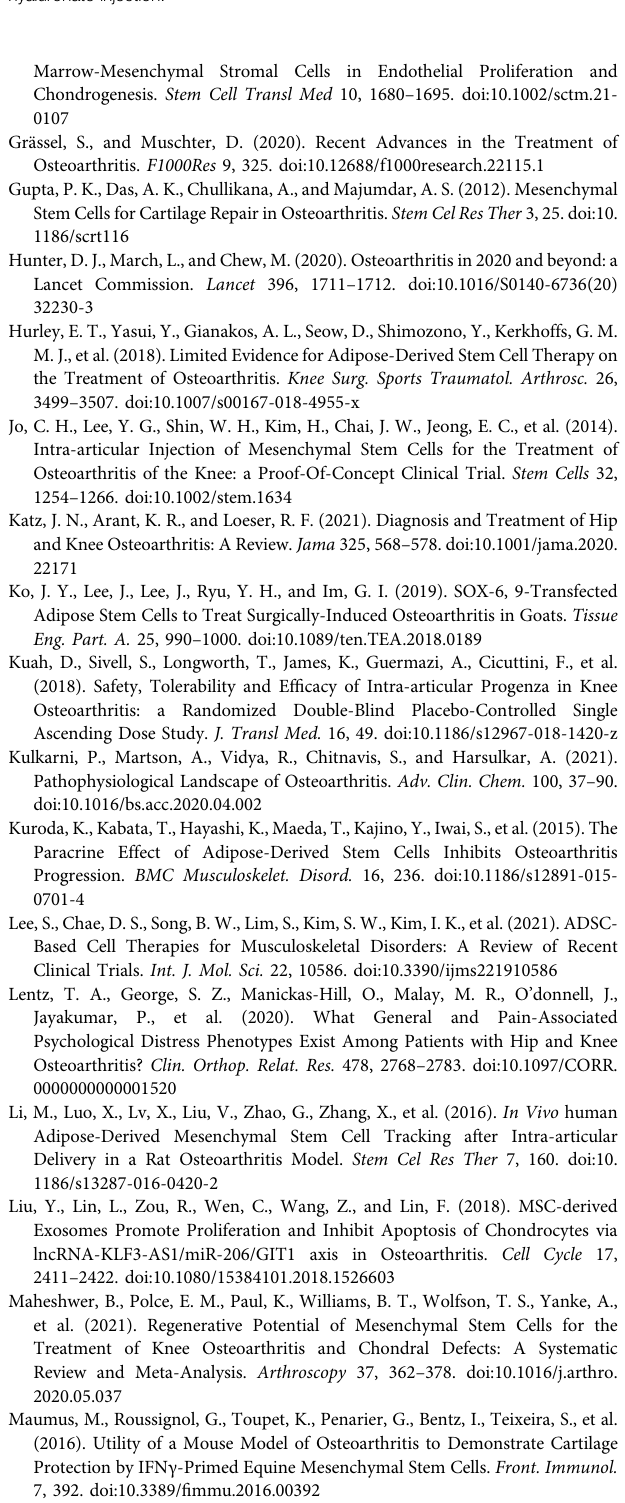
Sodium hyaluronate injection (2.5 ml/tube, certi fi cate number: H20140533) used in our clinic was purchased from Seikagaku Corp. (Chiyoda-ku,